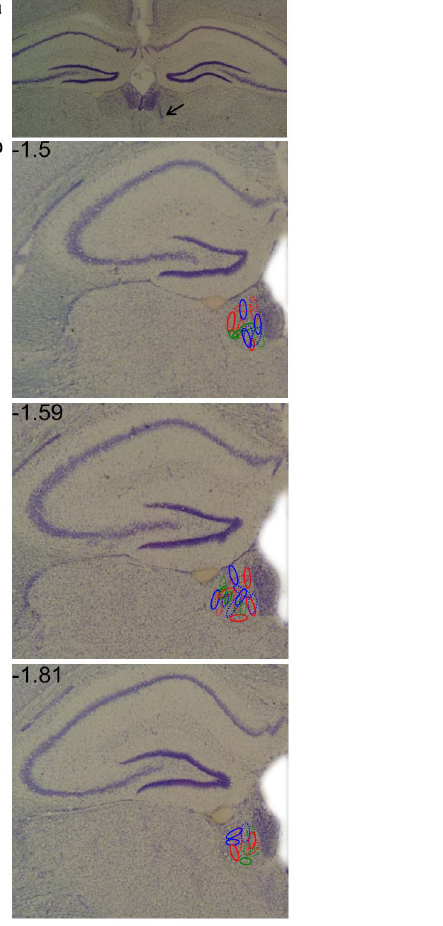
Figure 1. Localization of electrode positions in the LHb. a) Section showing representative example of Cresyl violet and Prussian blue staining. Arrow indicates electrode position. b) Oval shaped symbols illustrate all electrode positions. Dashed oval symbols indicate subjects which received stimulation after acquisition. Green, blue and red colours indicate 20, 50 and 100 Hz stimulation respectively.